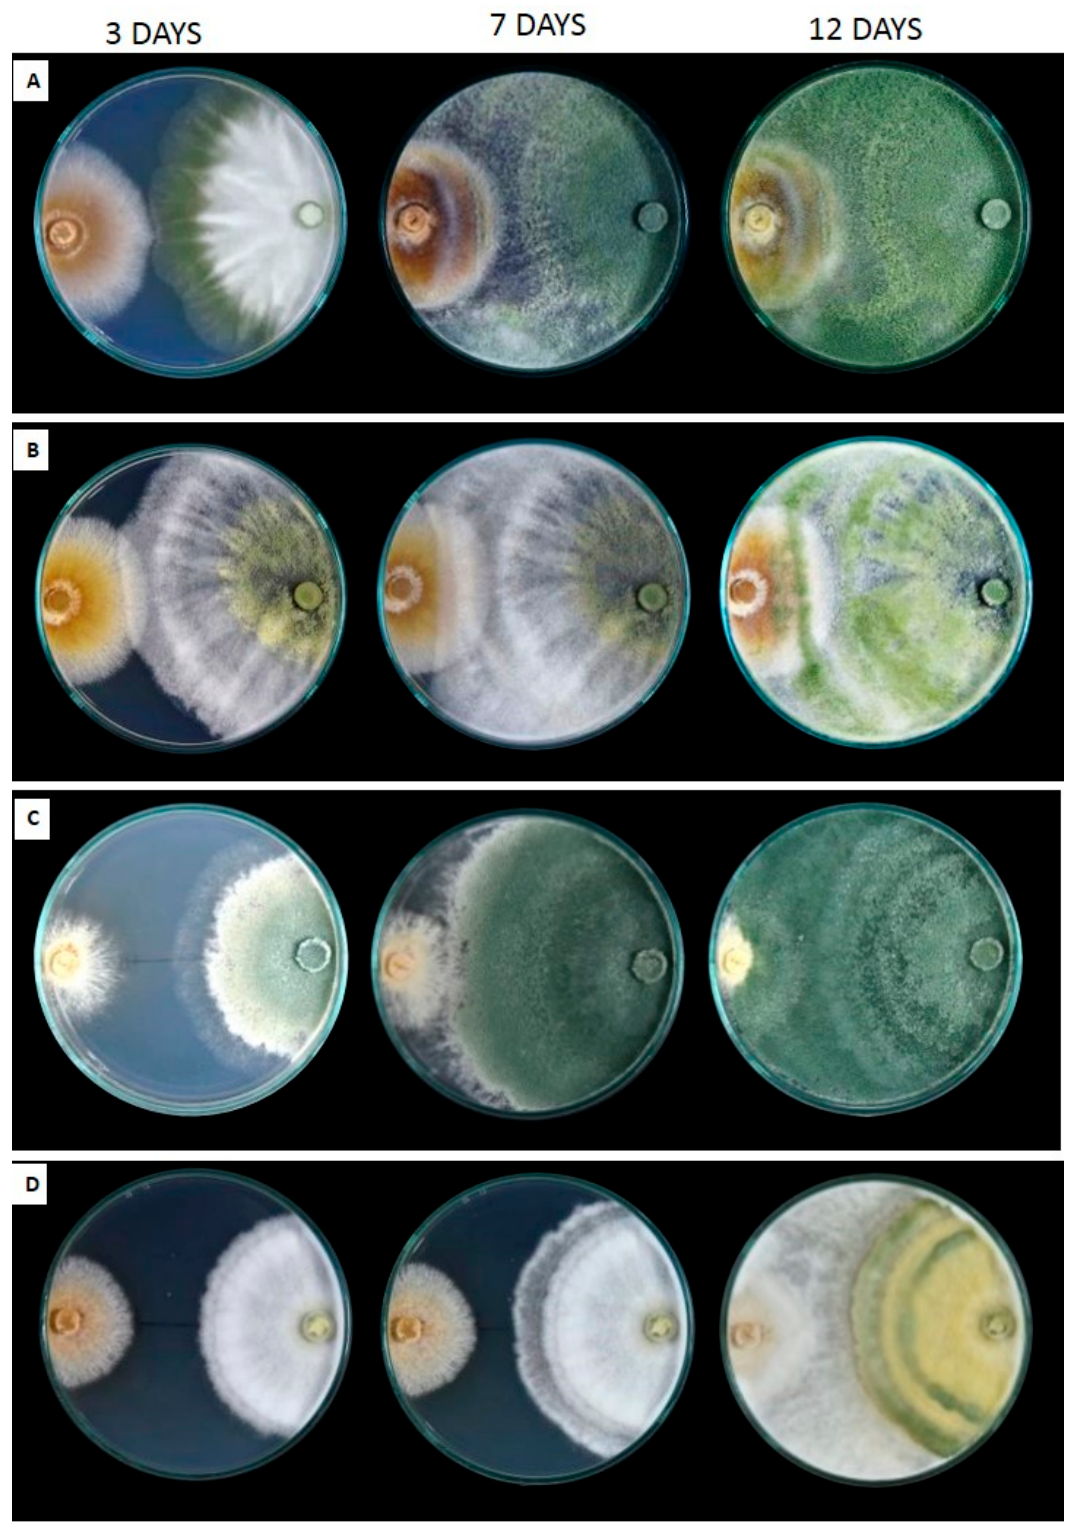
Figure A3. In vitro antagonism tests for: ( A ) CP 10-3; ( B) CP53-2; ( C ) CP24-6; ( D ) CP38-2. From left to right 3, 7, and 12-day-old cultures. In each dish, on the left FPR strain, and on the right Trichoderma strain.